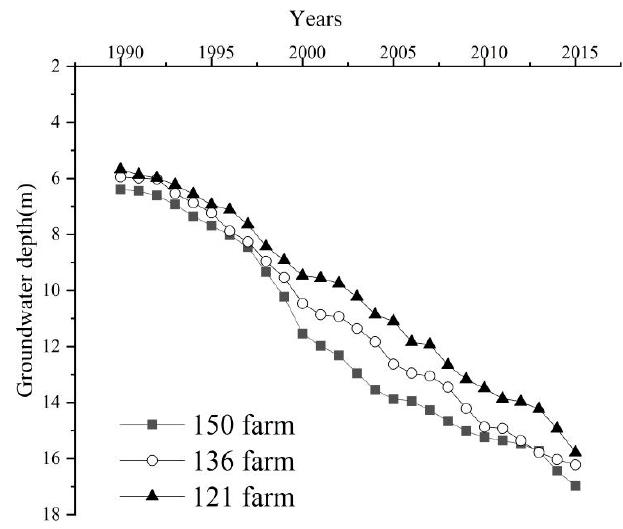
Figure 3. The change in groundwater depth at farms 150, 136, and 121 from 1990 to 2015.